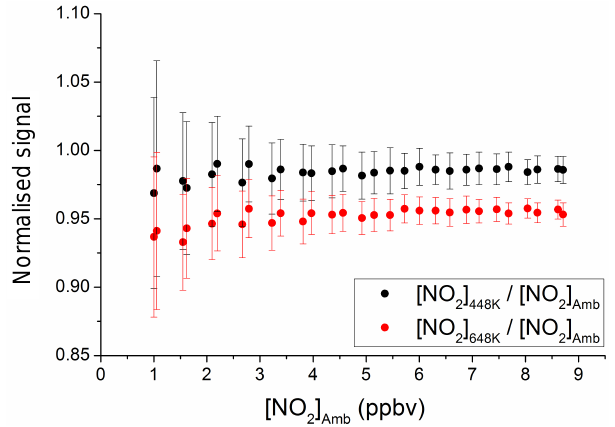
Figure 5. NO 2 loss in the heated inlets of the (cid:54) PNs and (cid:54) ANs channels. Black points represent the NO 2 mixing ratio measured in the (cid:54) PNs channel ([NO 2 ] 448K ) normalised to the NO 2 mixing ra- tio measured in the NO 2 channel ([NO 2 ] Amb ). Red points represent the NO 2 mixing ratio measured in the (cid:54) ANs channel ([NO 2 ] 648K ) normalised to the NO 2 signal measured in the NO 2